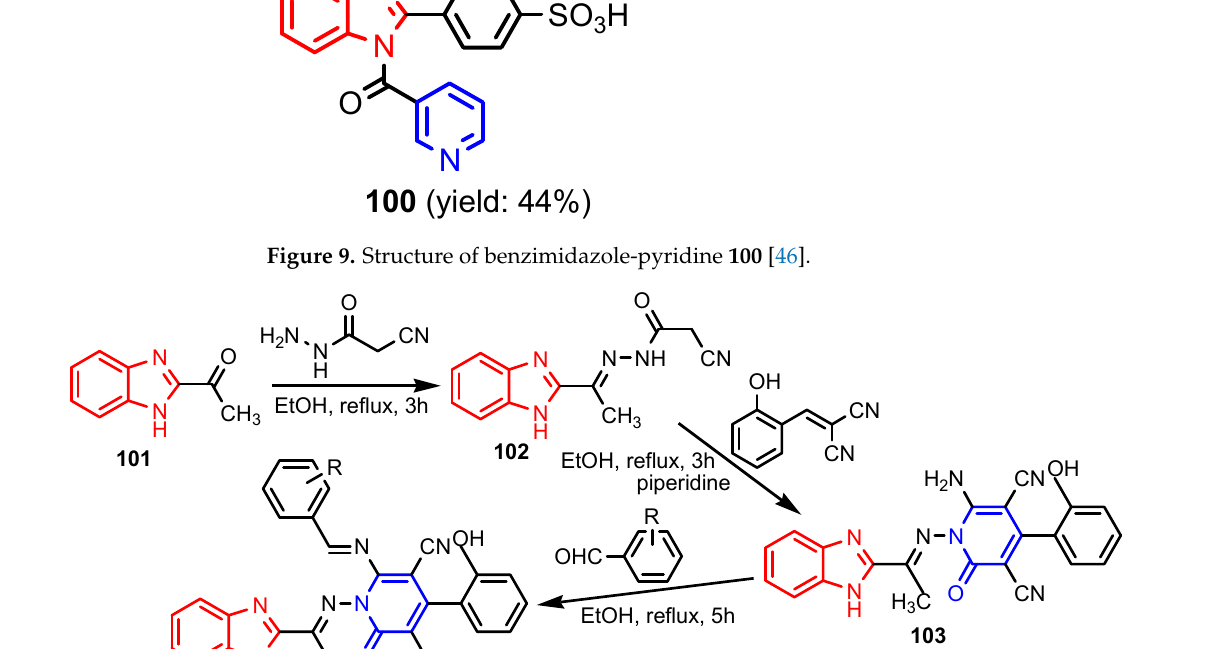
Figure 9. Structure of benzimidazole-pyridine 100 [46].